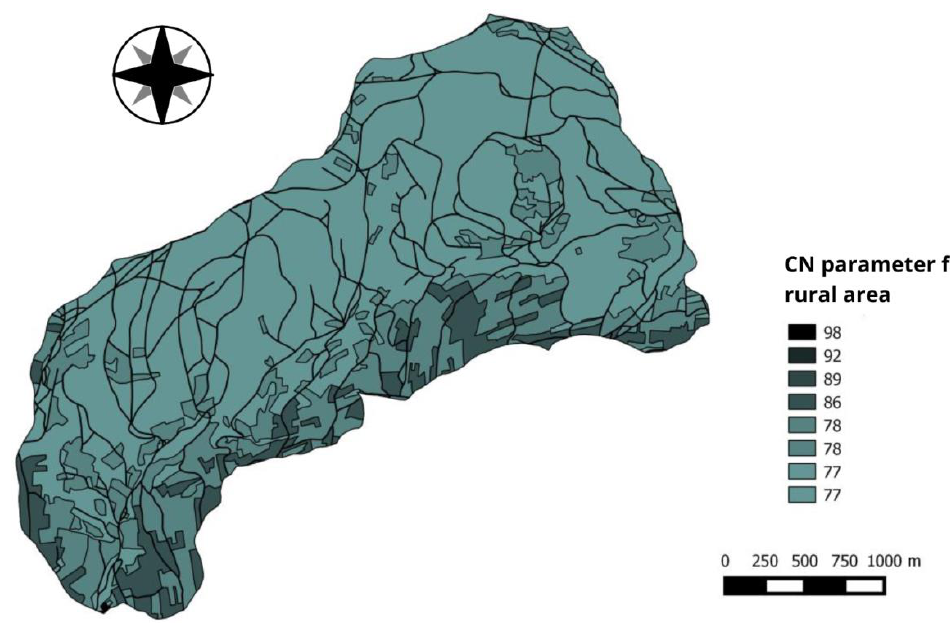
Water 2022 , 14 , x FOR PEER REVIEW Figure 4. Curve number for suburban area. Figure 4. Curve number for suburban area.